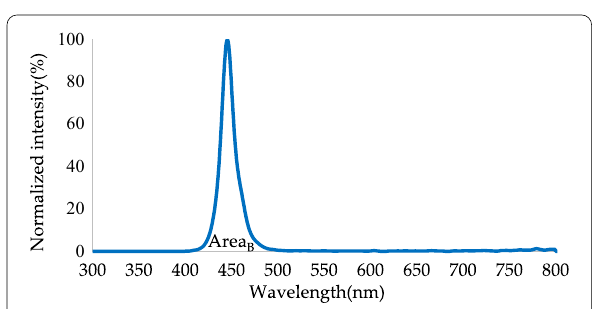
Fig. 7 Normalized spectrum of blue micro‑LEDs chip